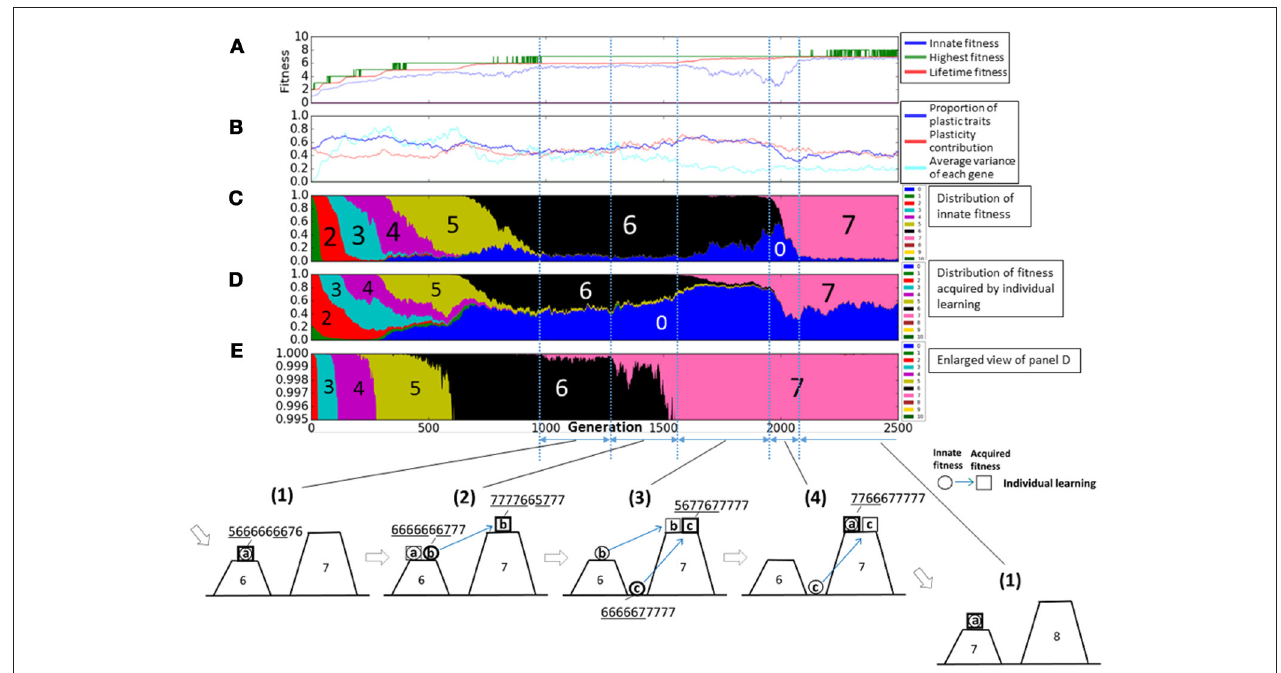
FIGURE 5 | Enlarged view of Figure 4 . (1–4) Illustrate typical phases of the evolution of the population on the rugged fitness landscape, each corresponds to the duration indicated by a double headed arrow. Each individual is represented as a pair of a circle, showing its innate fitness, and a square, showing its lifetime fitness. The circle and the square are connected with a directional arrow, representing its learning process. Thick circles and squares represent dominant individuals in the population.